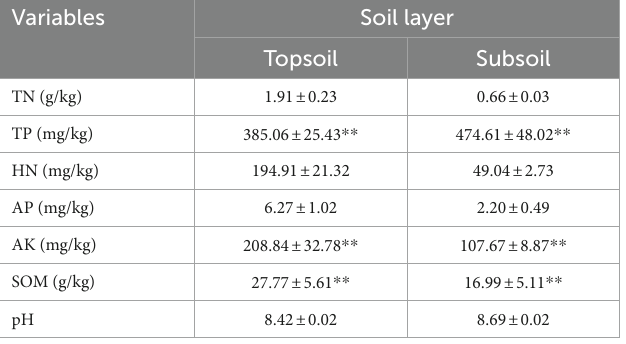
TABLE 1 Soil physicochemical properties in the topsoil (0–30 cm) and subsoil (30–100 cm).